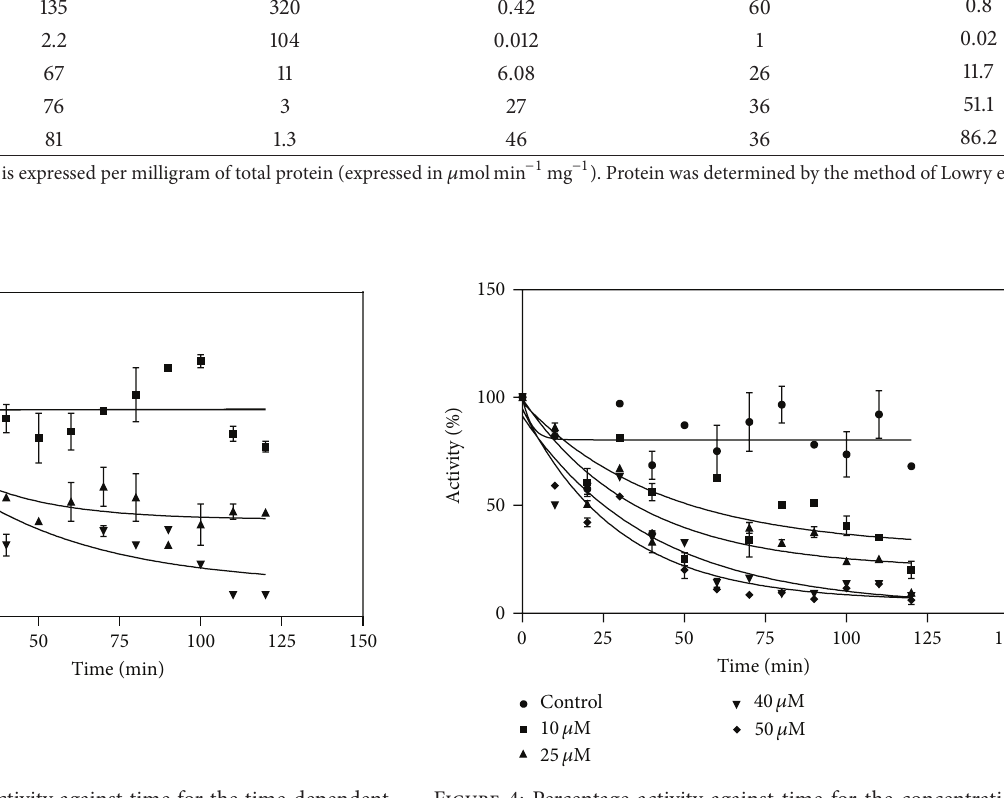
Figure 3: Percentage activity against time for the time-dependent inactivation of AgGST 𝜀 2 by Tral 1 and ETA. The activity was determined every 15min over a 2h period. The 𝑡 1/2 was determined by nonlinear regression.